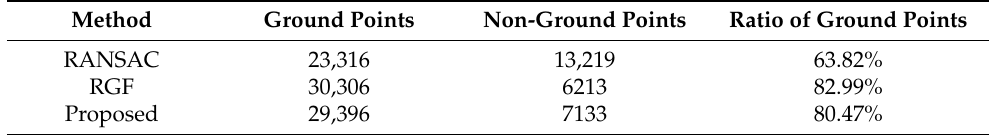
Figure 8. The enlarged comparison of Section C and Section D in Figure 7. ( a ) Section C in Figure 7. ( b ) Section D in Figure 7. ( b ) Section D in Figure 7. Table 1. Statistics of ground points and non-ground points in Figure Table 1. Statistics of ground points and non-ground points in Figure 7.